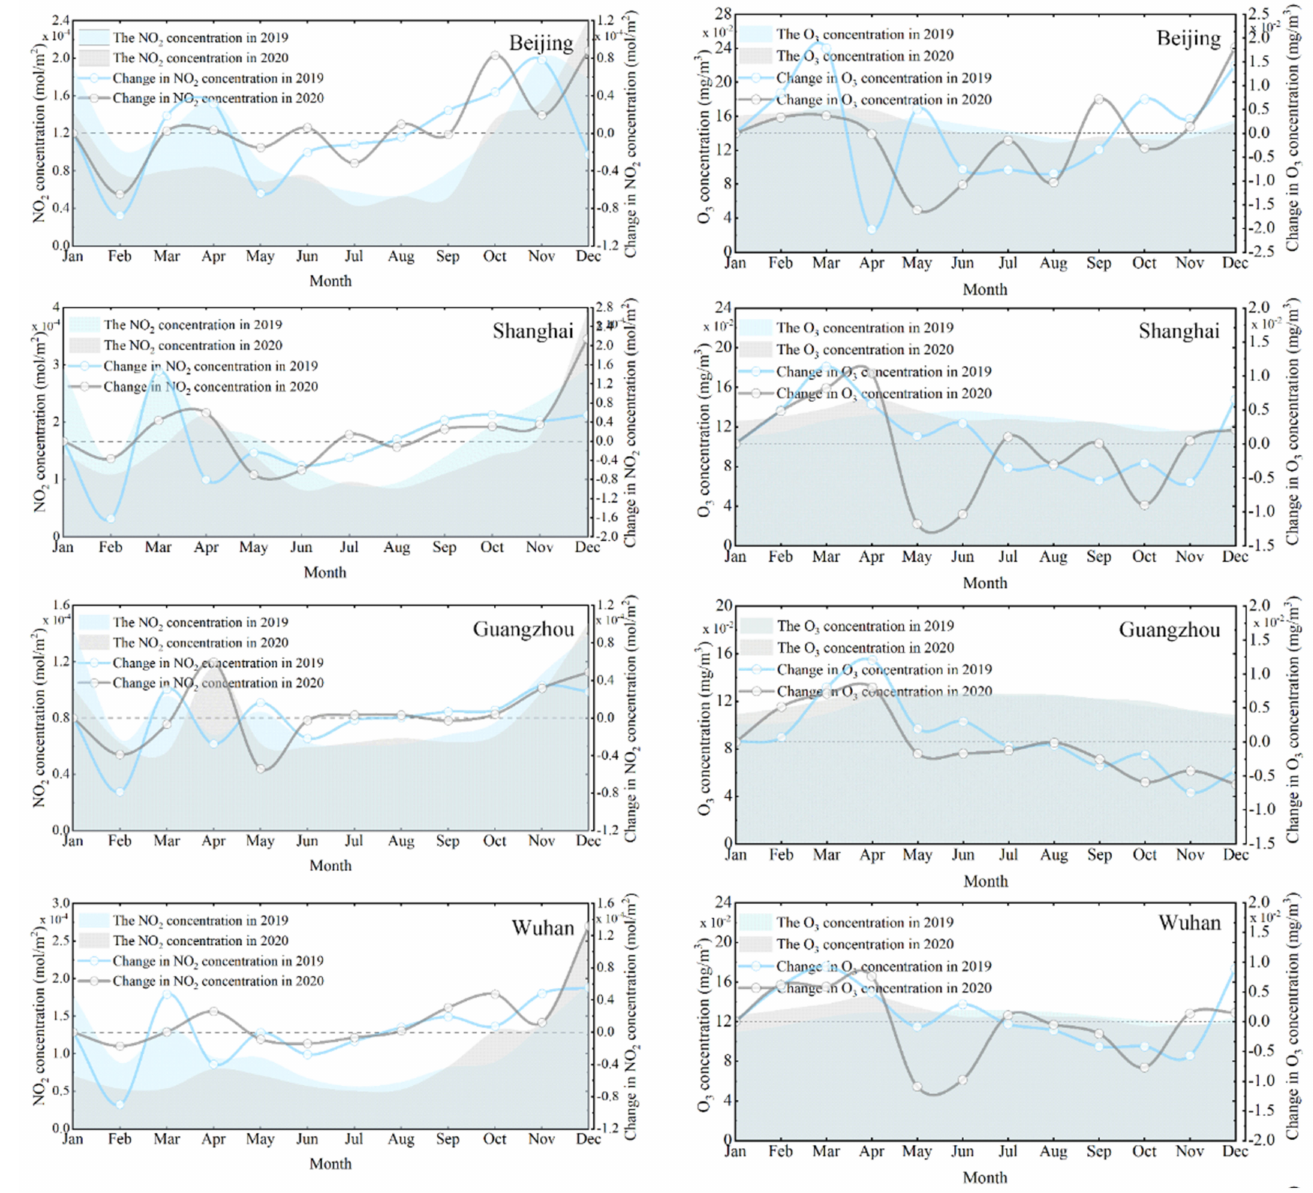
Figure 6. Concentration and increment change in NO 2 and O 3 in 2019 and 2020, respectively. The blue and gray areas in the figure represent the monthly averaged concentrations of NO 2 and O 3 in 2019 and 2020, respectively. Moreover, the blue and gray curve represents the monthly averaged increase in NO 2 and O 3 in 2019 and 2020, respectively. This increment represents the concentration increase in the current month compared to the previous month, which corresponds to the axis on the